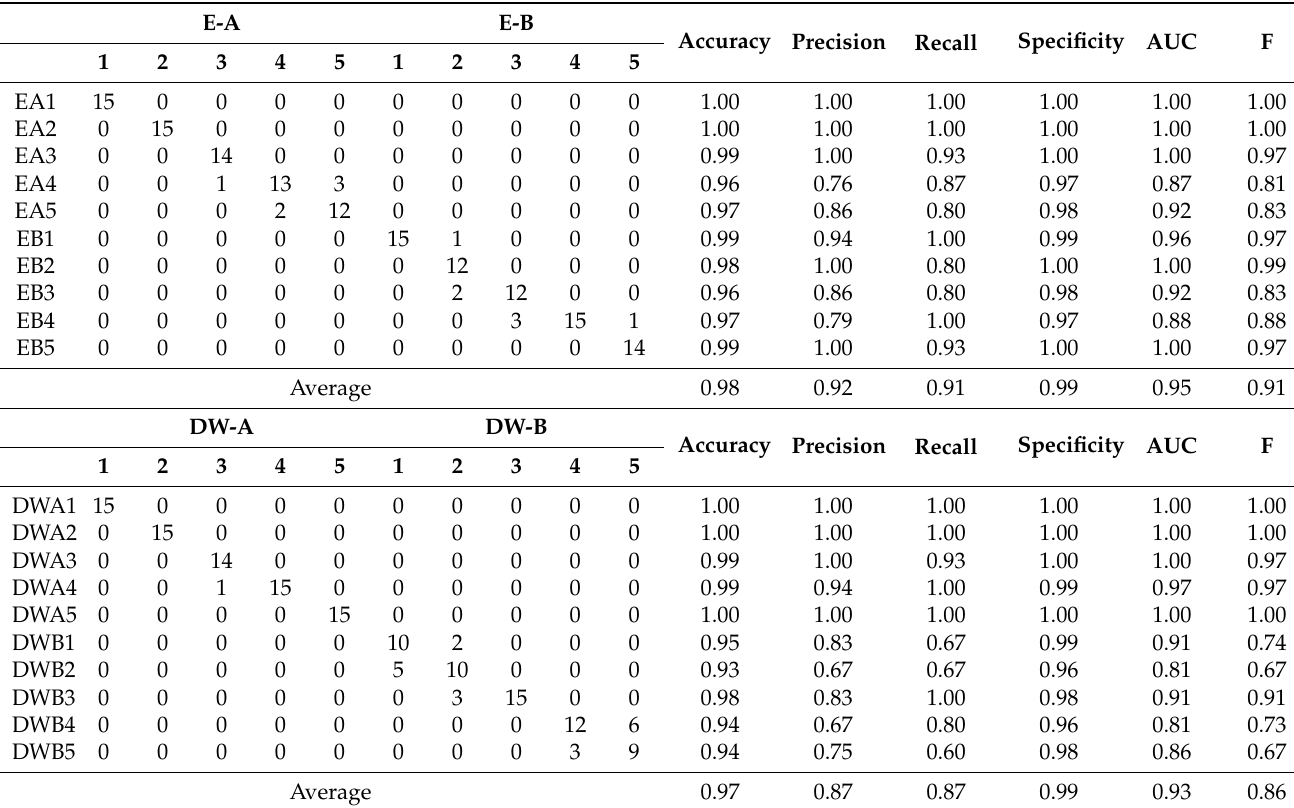
1 Symbols for hydrodistillation sample types: E = essential oil fraction, DW = distillate from water fraction; A = leaf samples dried in the shade, B = leaf samples dried in the shade. Hyphens are used in column headings to separate sample type from drying